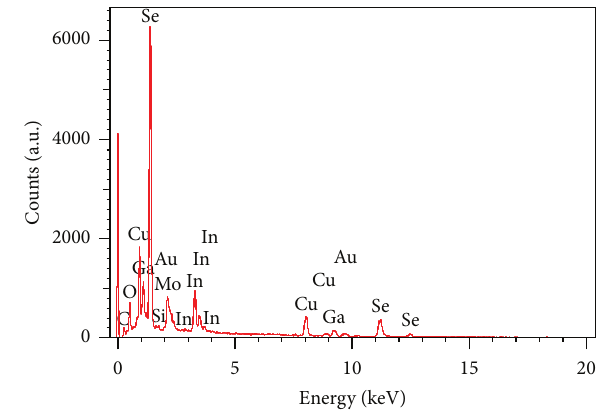
Figure 2: EDS photograph of CIGS sample before sintering.